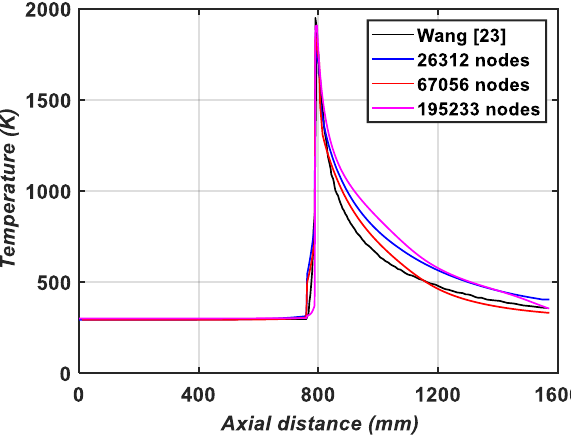
Figure 3. Comparison of the grid independence solutions of axial temperature.